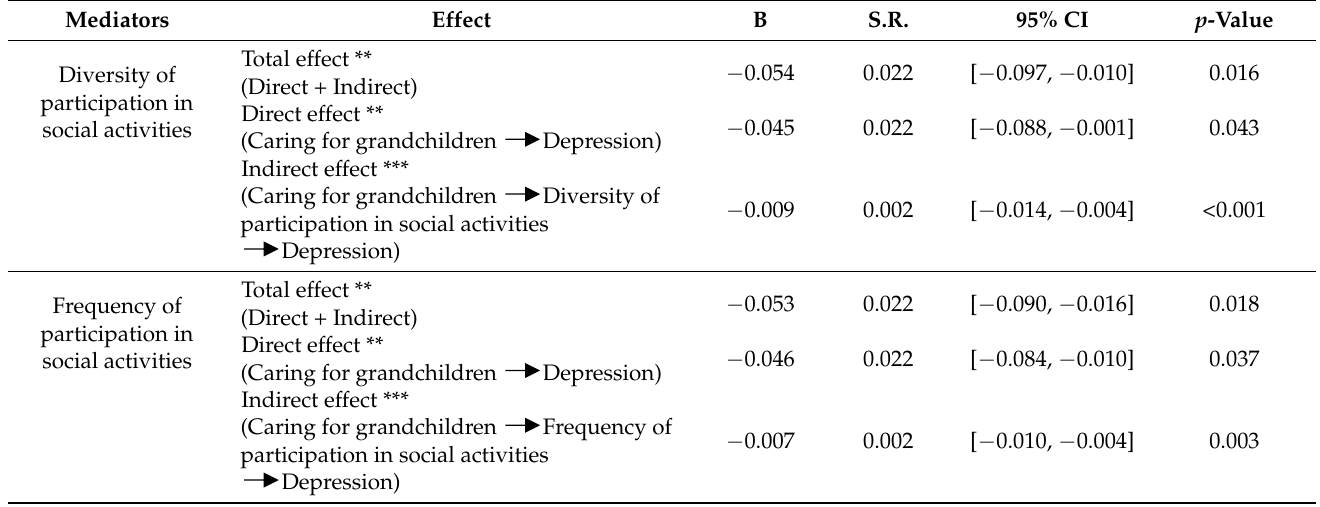
Table 6. Direct, indirect, and total effects of caring for grandchildren on depression of the elderly.